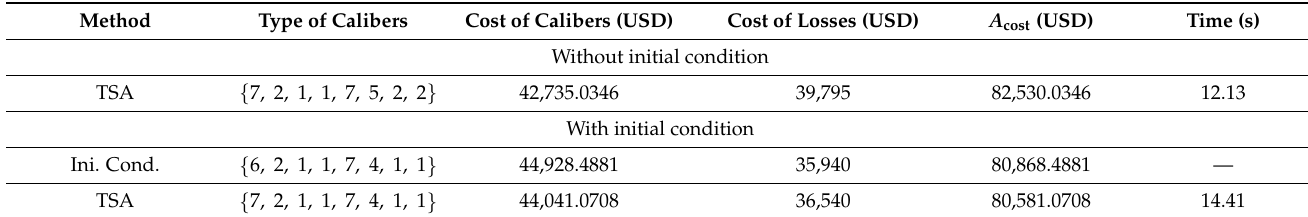
Table 10. Numerical results for the 9-bus system with the alternative